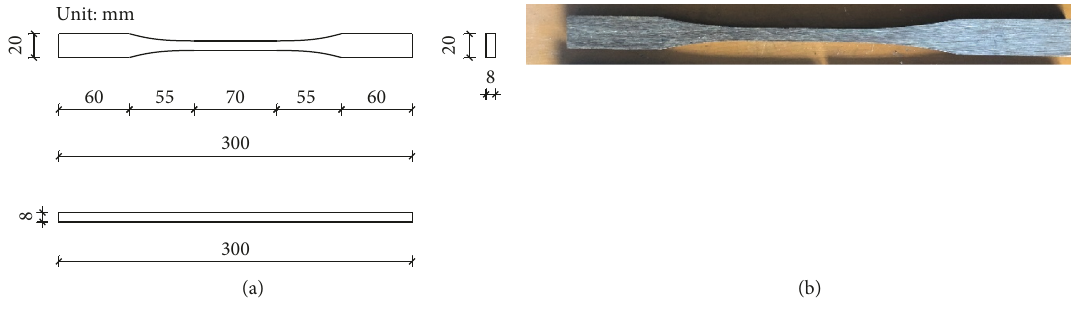
Figure 1: Tension specimen: (a) dimensions and (b) processed.